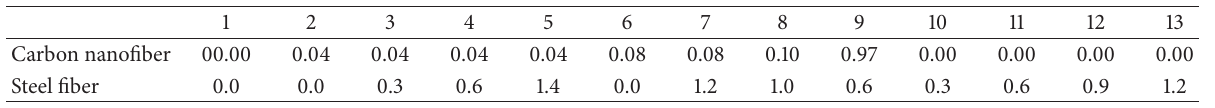
Table 2: Volume percents with respect to anhydrous cementitious materials (concrete) of steel fiber and carbon nanofiber in the optimization experimental program.